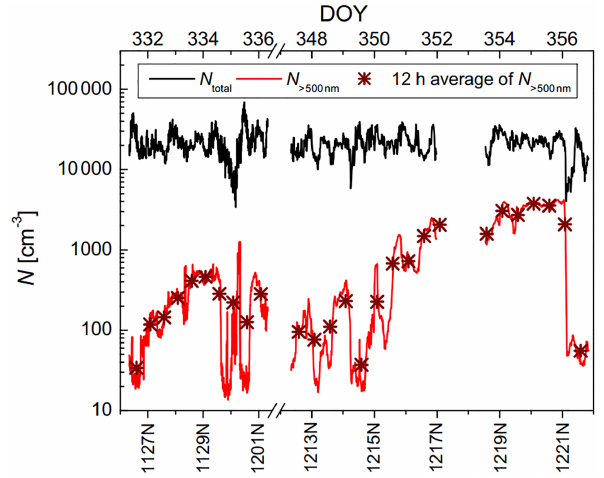
Figure 4. The time series of N total , N > 500nm and 12h average N > 500nm at − 16 ◦